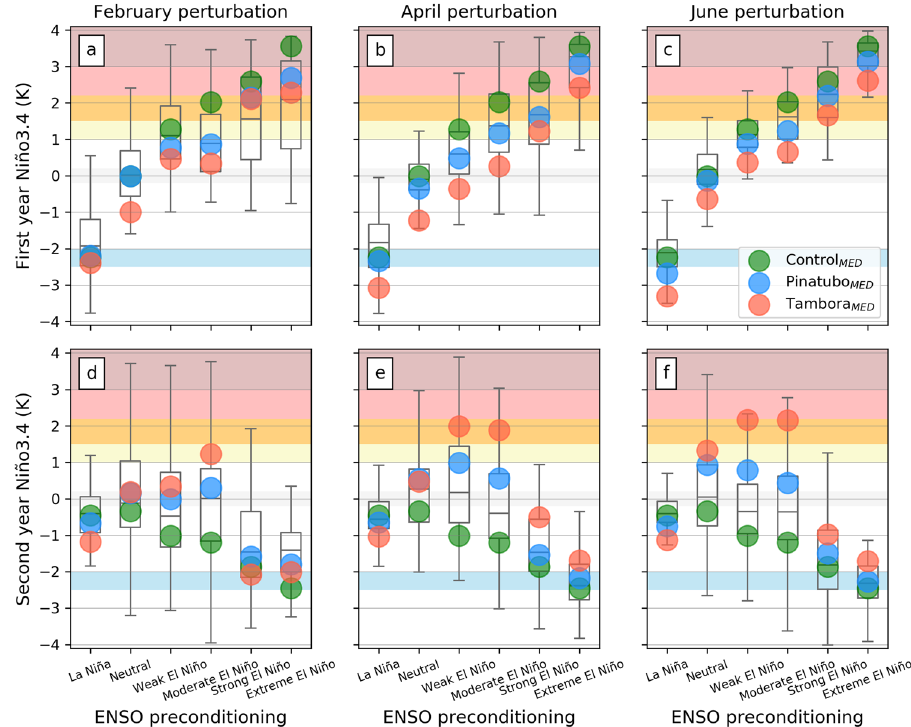
Fig. 2 Summary of the ENSO states in the fi rst and second year after the perturbation. Niño3.4 (K) averaged over the fi rst-year boreal winter (OND 1991) after the a February, b April, or c June perturbations. Green dots show the 10-member medians of the unperturbed control ensembles, for various types of ENSO events identi fi ed in the control run (abscissa; see Experimental setup for event de fi nitions). Box-and-whiskers show the distribution (median, quartiles, extrema) of the 100-member Butter fl y grand-ensemble; blue dots show the median of the 100-member Pinatubo grand-ensemble; red dots show the median of the 100-member Tambora grand-ensemble. Horizontal shaded bands indicate the Niño3.4 ranges for the various ENSO onsets de fi ned in Experimental setup: La Niña (blue), Neutral (light gray), weak El Niño (yellow), moderate El Niño (orange), strong El Niño (red), and extreme El Niño (dark red); ( d – f ) as in ( a – c ), but for Niño3.4 averaged over SON 1992. Full time-series of the control and perturbed ENSO states is shown in Supplementary Fig.